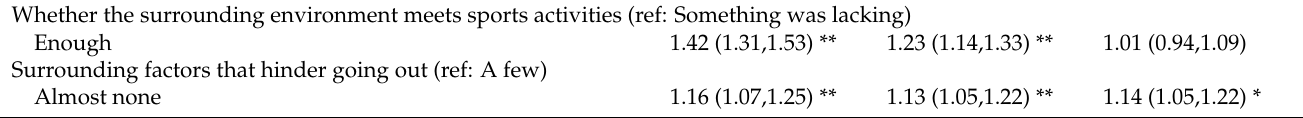
In Table 4, the “all non-meet-guideline group” among the eight combinations of three health-related behaviors was used as the control group, and the remaining seven groups were subjected to binary logistics regression analysis, and the OR values obtained were filled in the table for drawing. The regression analysis chart of controlling the children’s demographic factors is shown in Attached Tables A2 and A3. Comparing the three